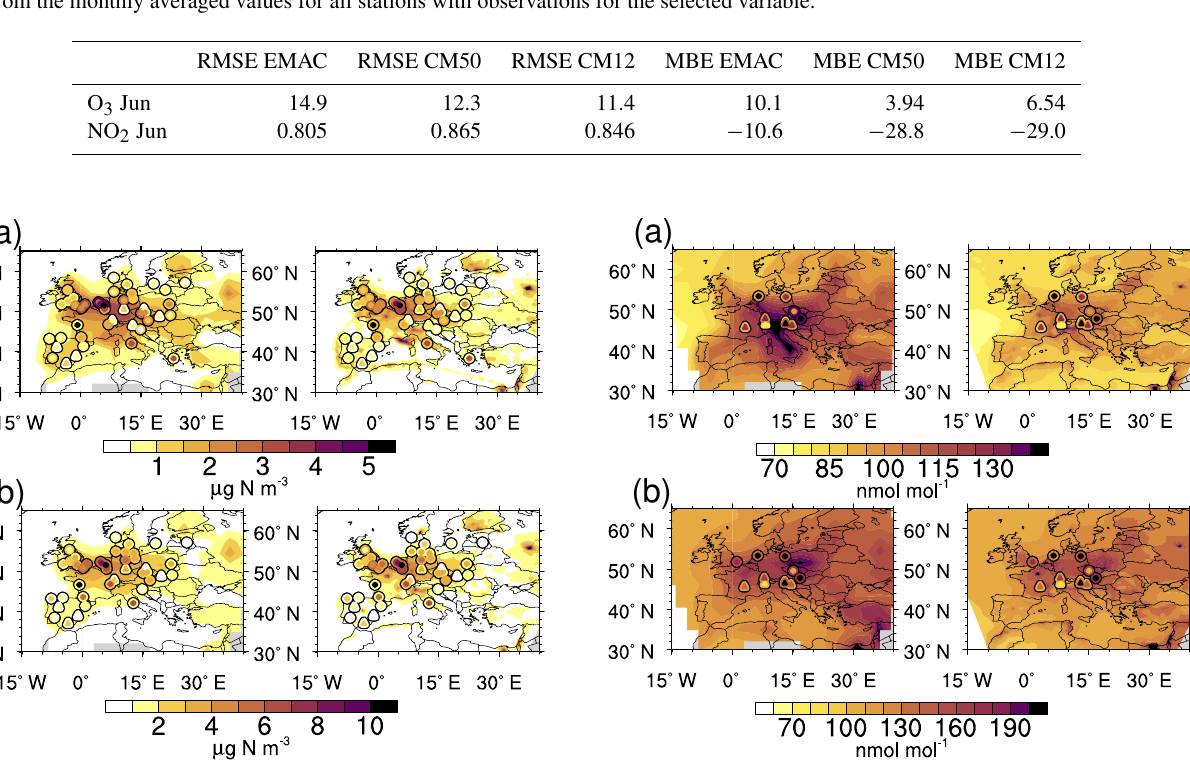
Figure 7. Monthly averaged carbon monoxide mixing ratios (nmolmol − 1 ) at the lowest model layer in (a) June and (b) De- cember 2008 from EMAC (left) and CM50 (right). The inner parts of the coloured dots show the monthly mean values measured at the corresponding stations, while the outer parts depict the simulated value corrected for the station elevation. Triangles indicate stations higher than 800m, circles stations below that